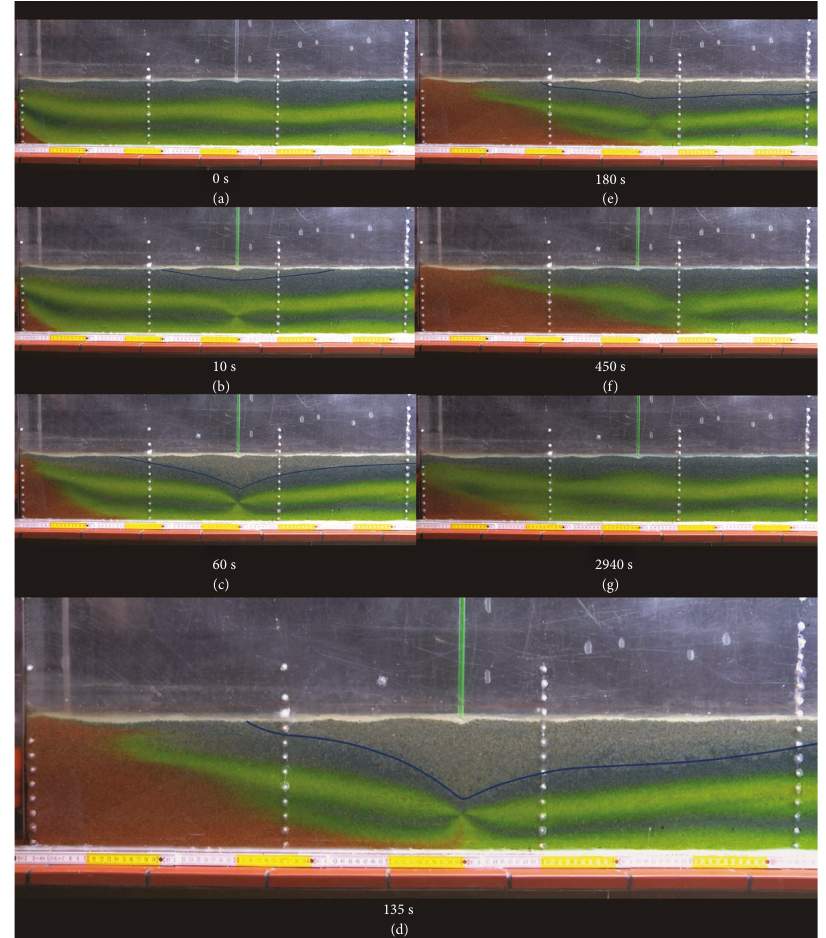
Figure 3: Excerpt view of the physical experiment (left-hand side and pump location) at seven di ff erent times (a-g) between t = 0s and t = 2940 s . Red is saltwater, while yellow and blue colours indicate freshwater fl ow paths. The cone of depression is drawn by hand (blue line), interpreted from the unsaturated greyish area visible in the